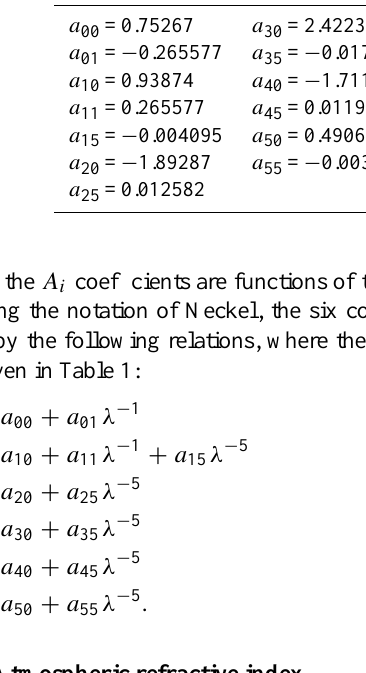
Table 1. Values attributed to the limb darkening coefficients as given in Neckel (2005) for wavelengths belonging to the spectral range